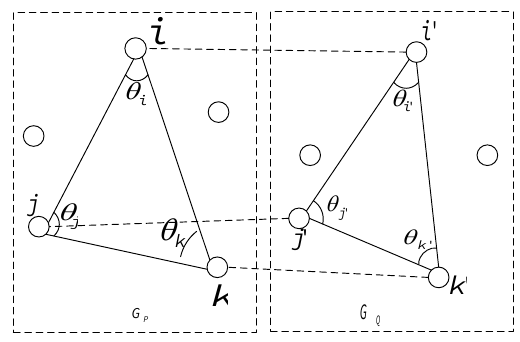
Figure 2 Geometry constraint based on similar